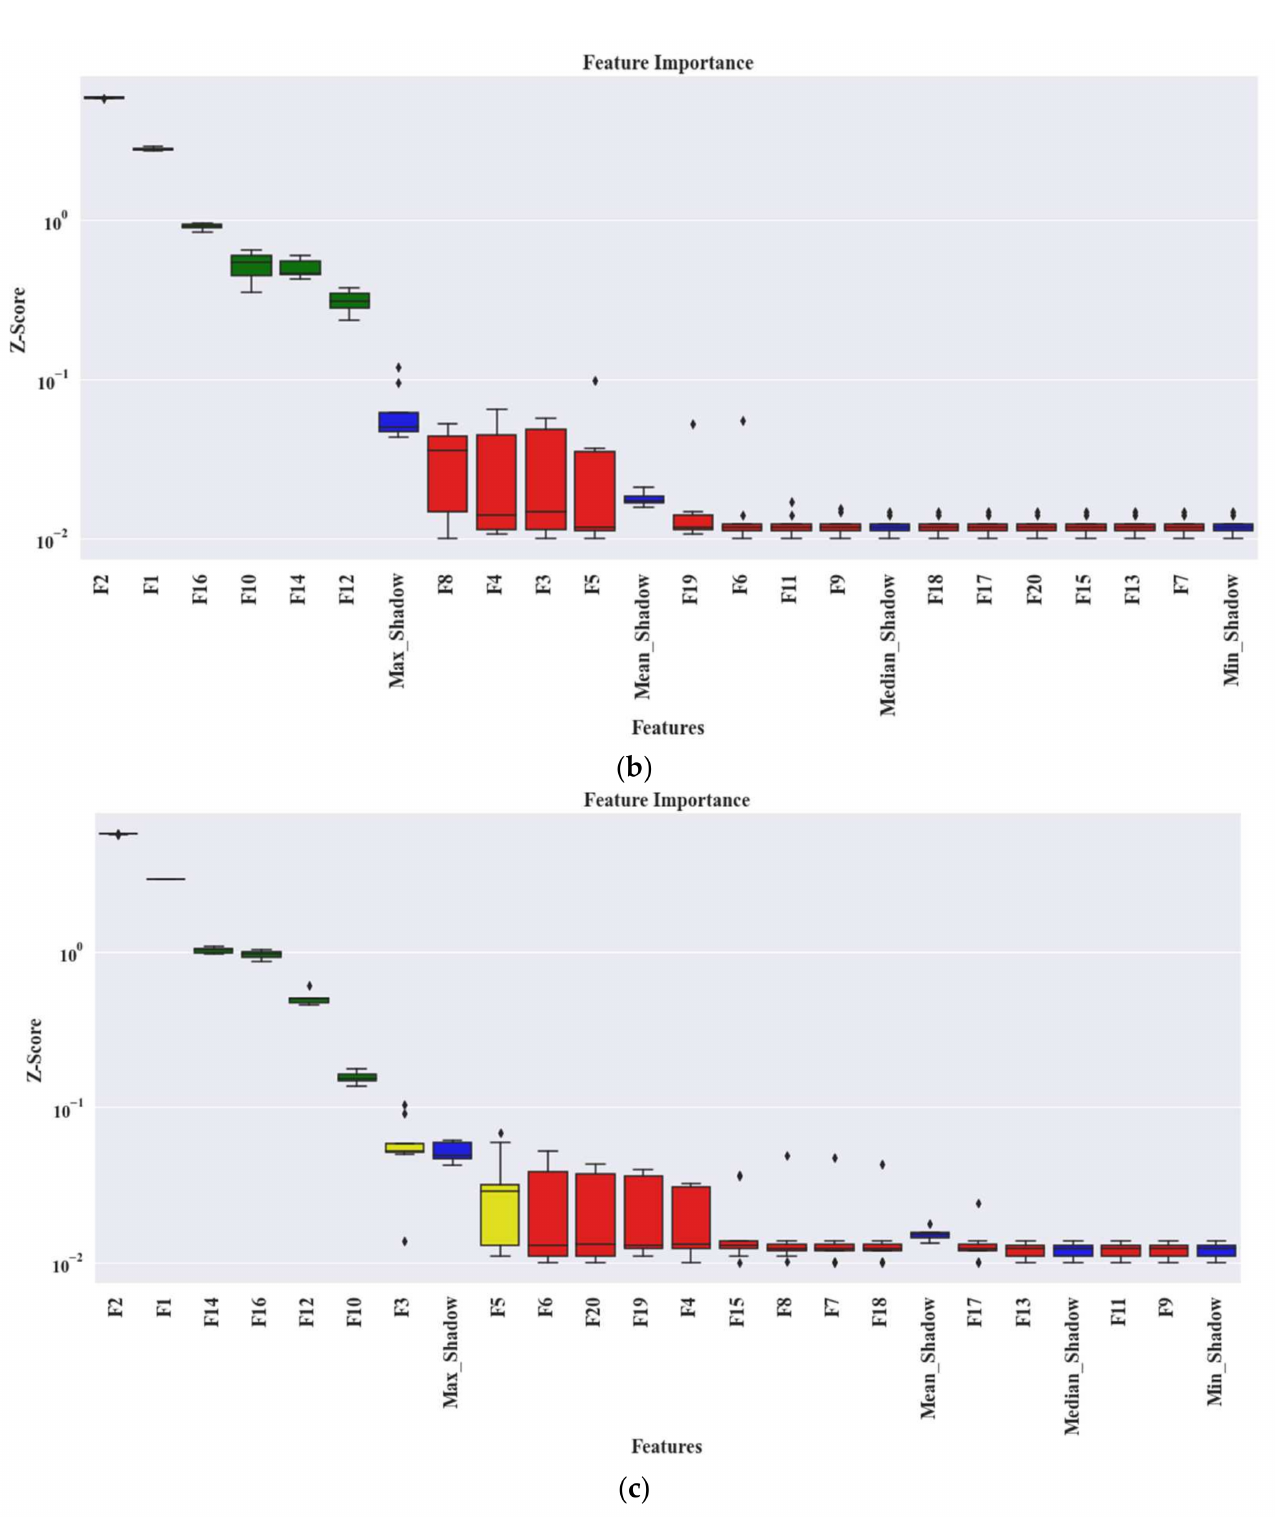
Figure 11. The box-whisker plot presenting Z scores generated by Boruta for each feature associated with all the datasets, i.e., ( a ) dataset 1, ( b ) dataset 2, and ( c ) dataset